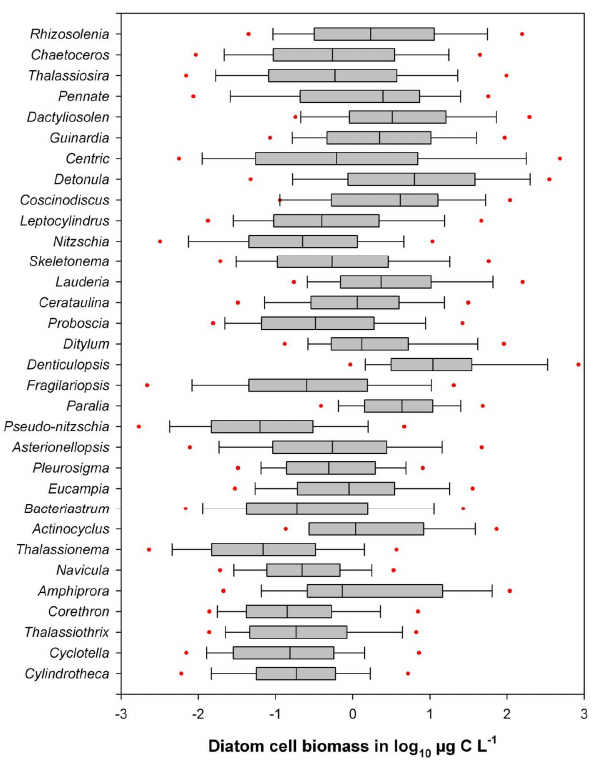
Figure 8. Boxplot of the main diatom genera, contributing to 99% of the total biomass (log 10 µ gCl − 1 ) in the database. Red dots rep- resent the 5th and 95th percentiles. Genus contribution to total biomass is arranged in decreasing order of abundance from top to bottom (see Table 2 for relative importance).